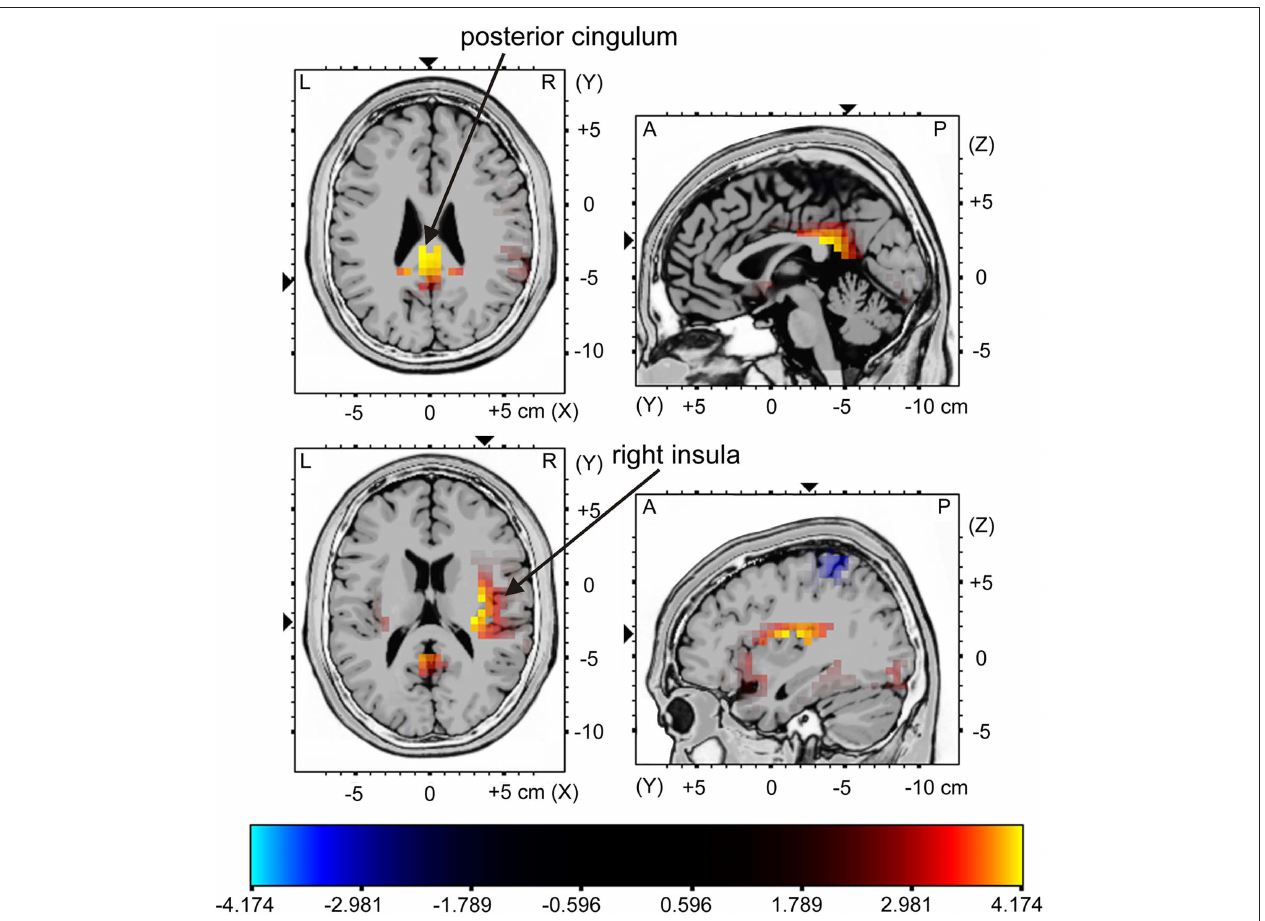
Figure 6 | sLoreTa contrast of the P300 for the young participants in non-target trials directly preceding correctly classified target stimuli vs. missed target stimuli . The red to yellow color represents voxels which show higher activation for the trials preceding correctly classified targets vs.